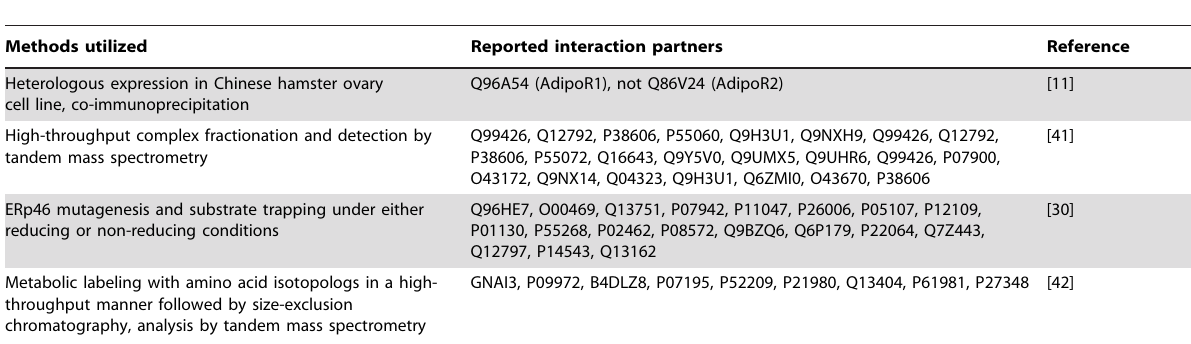
Table 2. Comparisons of the different interaction partners of ERp46